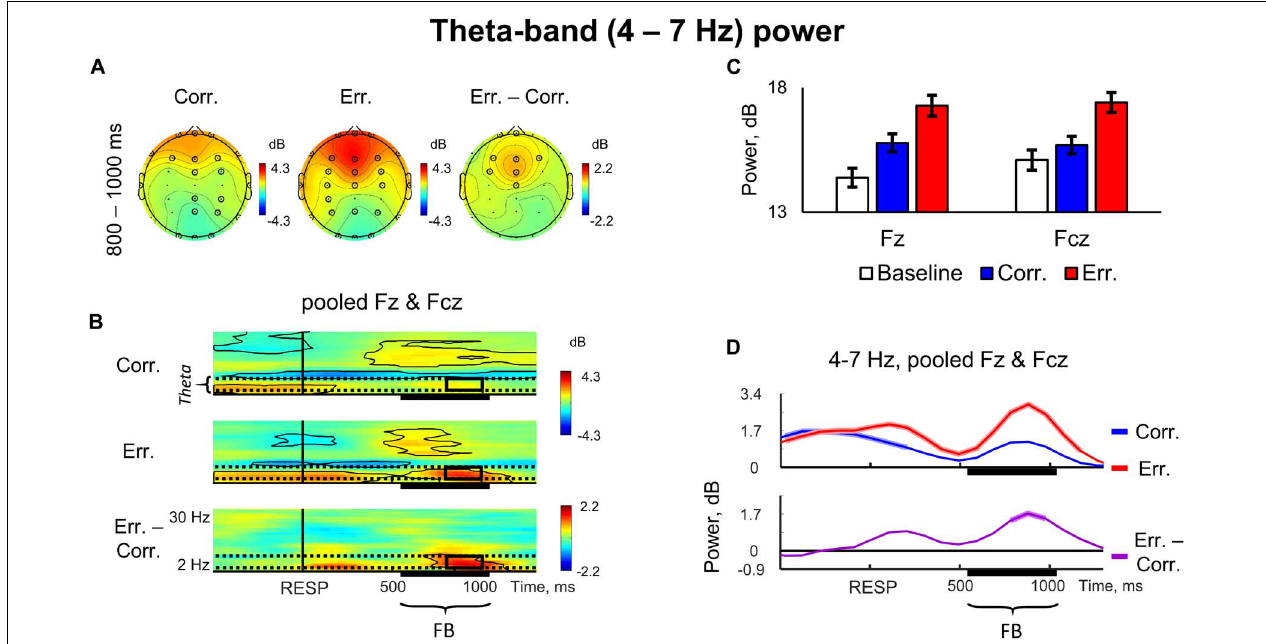
FIGURE 3 | Non-phase locked theta-band power. (A) Topographical maps of baseline-corrected theta band activity at 800 – 1000 ms relative to response (left map represents correct responses, middle map – errors, and right map – difference: errors minus correct responses). Significant electrodes are highlighted with black circles ( p < 0.05, TFCE, permutation statistics). (B) Time-frequency plots of baseline-corrected averaged event-related spectral perturbation (ERSP) data at pooled electrodes Fz and Fcz (top plot – correct responses, middle plot – errors, and bottom plot – difference: errors minus correct responses). Black outlines indicate p < 0.05 (TFCE, permutation statistics). Horizontal dashed lines over ERSP plots indicate theta (4–7 Hz) frequency range. Black rectangles represent region of interest: theta frequency range, 800 – 1000 ms post-response time-window. Time is shown relative to the behavioral response. (C) Bar plots representing averaged ERSP data at Fz and Fcz electrodes, 800 – 1000 ms post-response time-window. Data are plotted as mean ± standard error of mean. (D) Timecourses of baseline-corrected theta activity averaged at pooled electrodes Fz and Fcz. Top subpanel: correct and error trials. Bottom subpanel: difference between erroneous and correct trials. Colored contours superimposed on timecourse lines represent statistical significance ( p < 0.05, TFCE, permutational statistics). Time is shown relative to the behavioral response. “RESP,” behavioral response; “FB,” feedback.